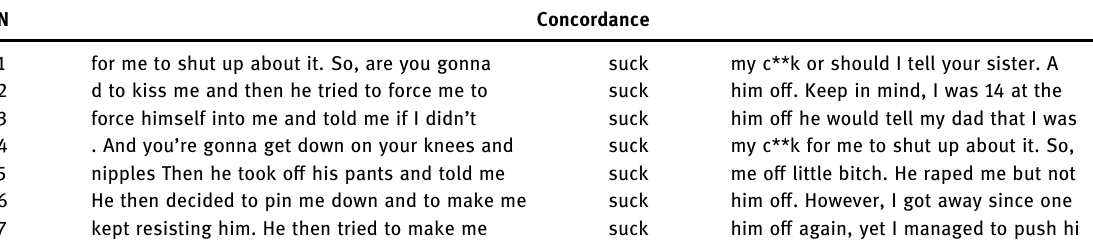
Table 30: Concordance lines for suck N Concordance